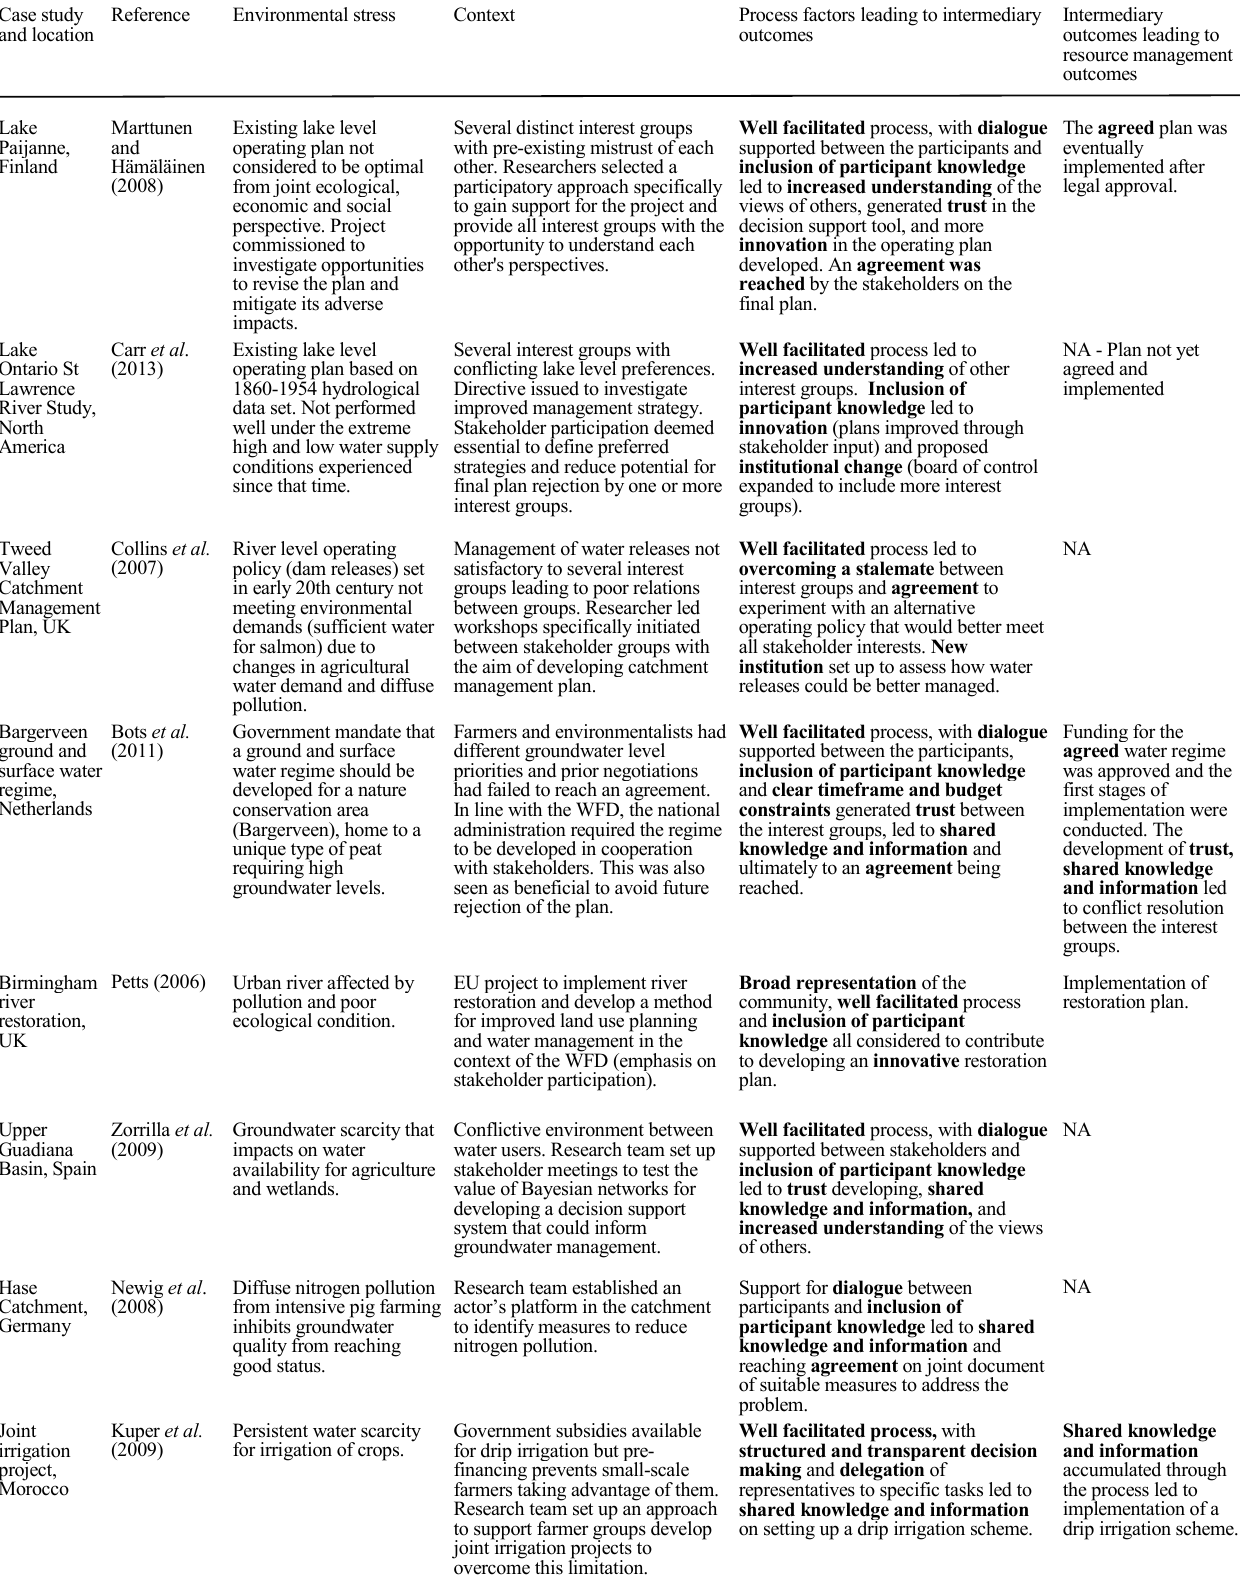
Table 1 Case study analysis findings ( processes , intermediary outcomes , resource management outcomes ) (WFD = European Water Framework Directive, NA = not